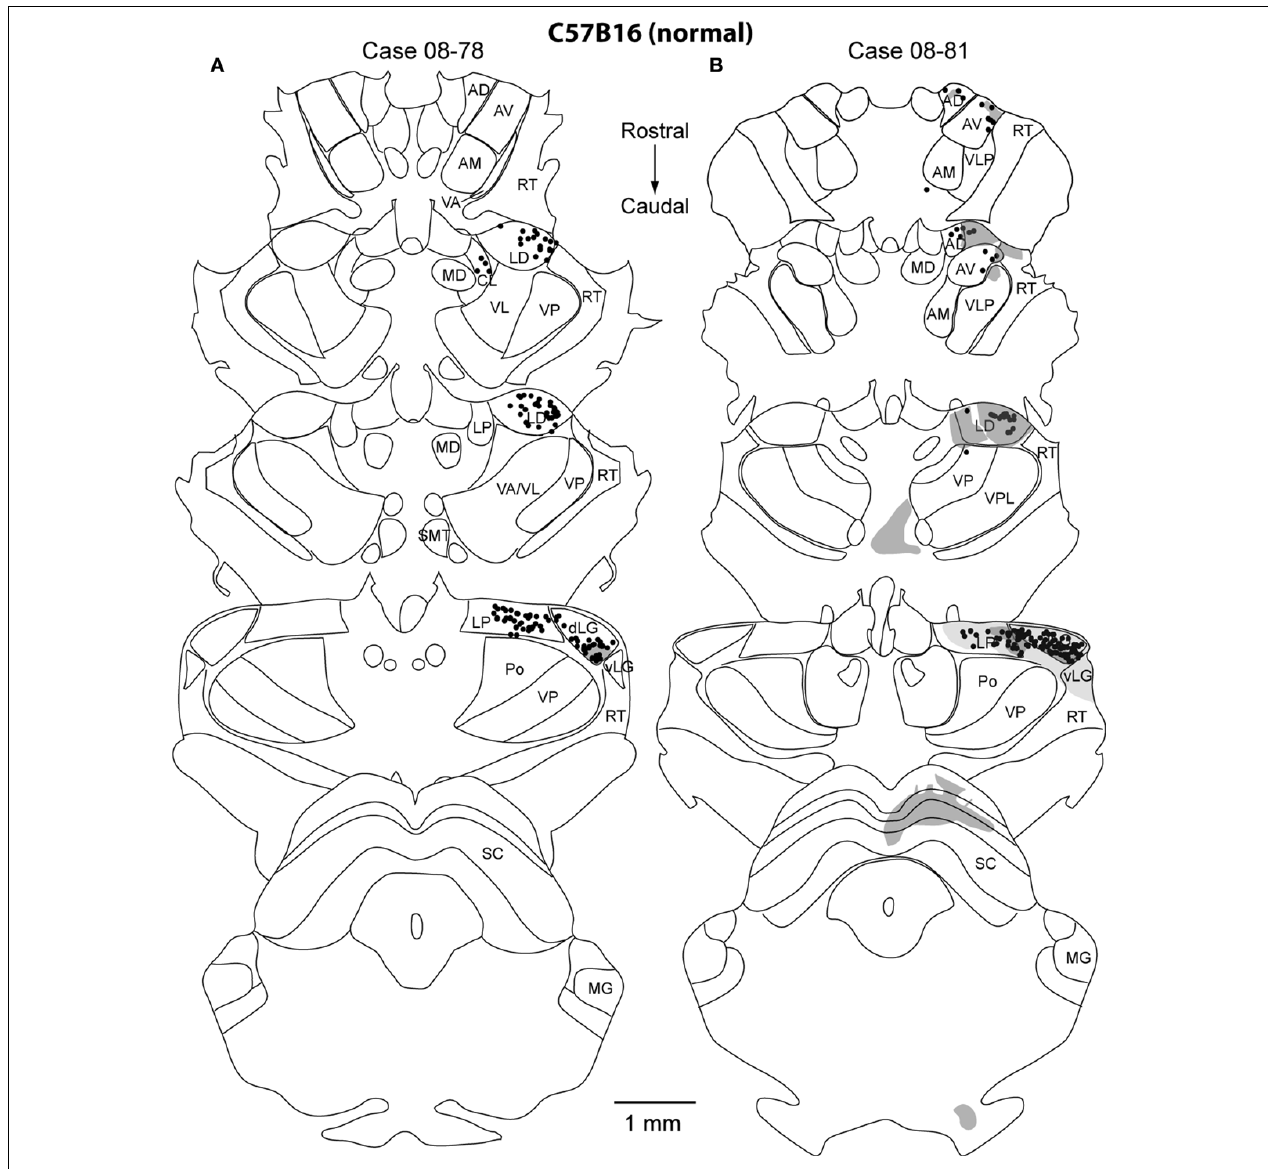
FIGURE 10 | Thalamic Reconstructions of Neuroanatomical Tracer Injections in C57Bl6 V1. Reconstructions of a series of thalamic sections sectioned in the coronal plane representing label from 2 injection sites in C57Bl6 (A,B) . The normal thalamocortical visual pathways (dLG, LD, LP) are found in the C57Bl6 mice. The dots mark the locations of labeled cell bodies and the shaded regions are areas of anterograde